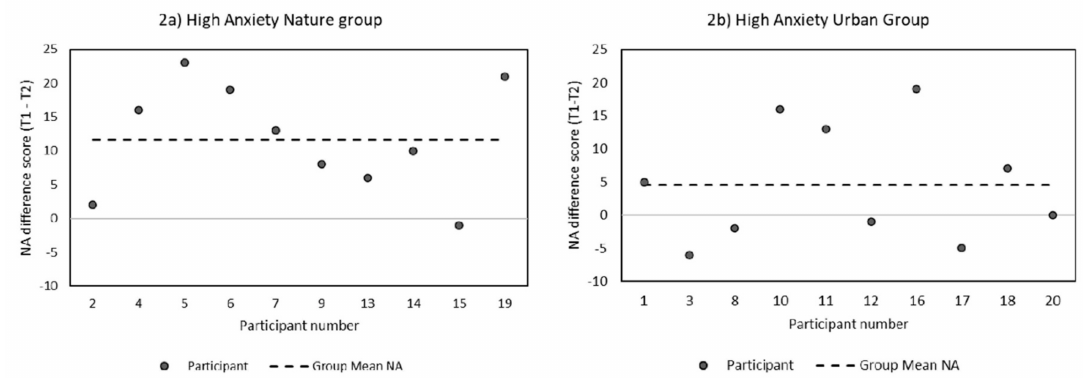
Figure 2. Scatter plots of pre-post di ff erences in negative a ff ect (NA) scores per participant in ( a ) the high anxiety nature group and ( b ) the high anxiety urban group. The dashed line represents the overall mean NA di ff erence score for the